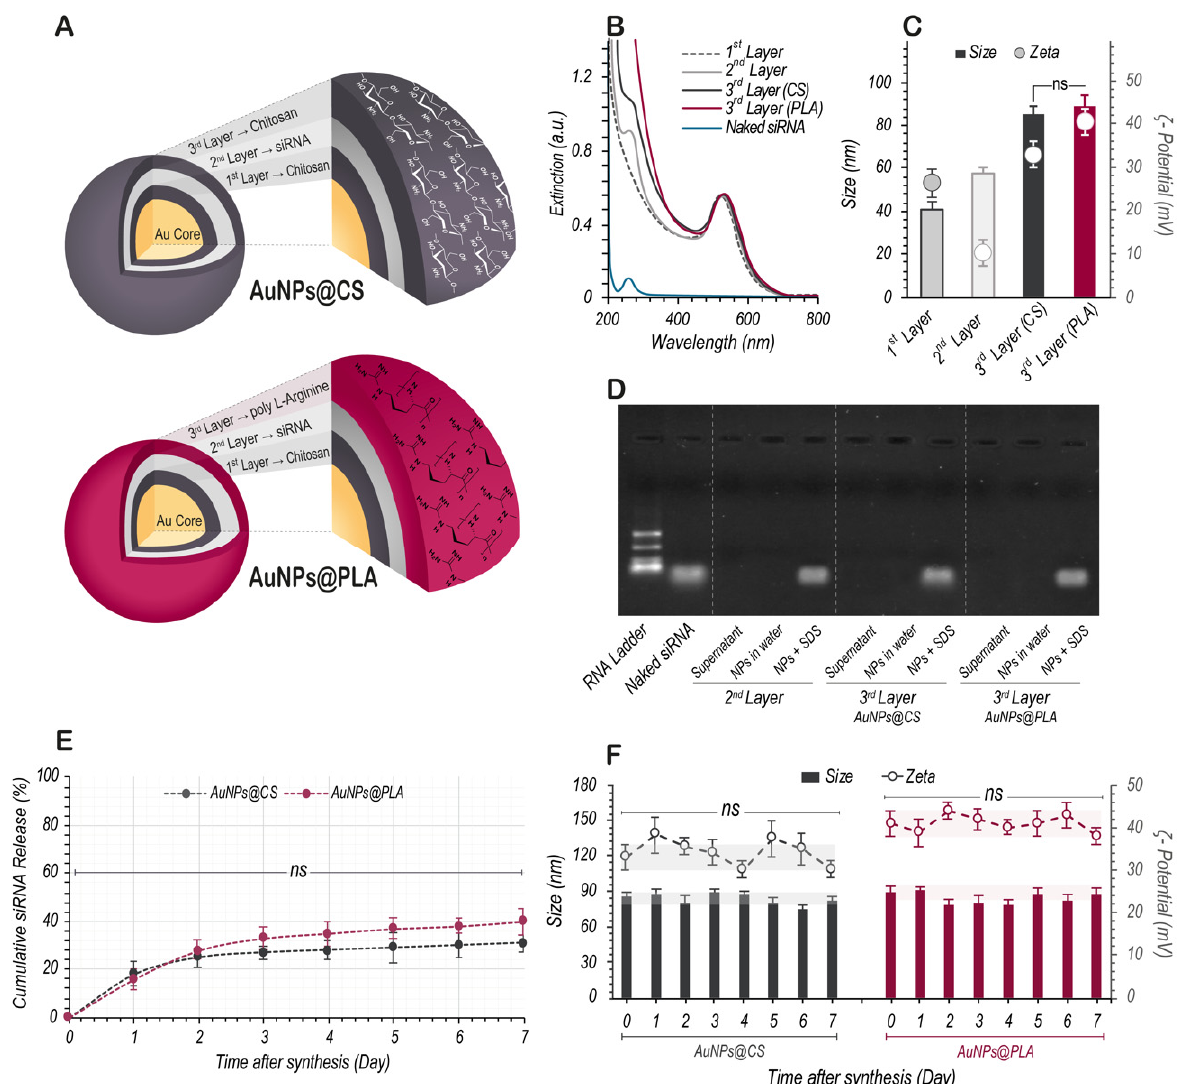
Figure 1. Characterization of layer-by-layer (LbL) synthesis of siRNA-AuNP nanoformulations with CS or PLA as outer layer. ( A ) Schematic representation of the LbL nanoformulations with either CS (AuNPs@CS) or PLA (AuNPs@PLA) as the 3rd and final layer. ( B ) UV–vis spectra upon sequential adsorption of the different layers in the LbL synthesis. ( C ) Particle size and zeta potential measured by DLS after sequential adsorption of the different layers in the LbL synthesis. ( D ) Agarose gel retardation assay of nanoformulations upon addition of each layer. After centrifugation, the supernatant was collected and the pellet of nanoformulations was redispersed in water or mixed with 20 mg/mL sodium dodecyl sulfate (SDS) for dissociation of siRNA from the nanoparticles. ( E ) Percentage of siRNA released from AuNPs@CS and AuNPs@PLA in pH 7.4 HEPES buffer at 37 °C as a function of time. ( F ) Size and zeta potential analysis in ddi water as a function of time for AuNPs@CS and AuNPs@PLA. Data are represented as mean ± the standard deviation of the mean for a minimum of three independent experiments (ns = not significant).